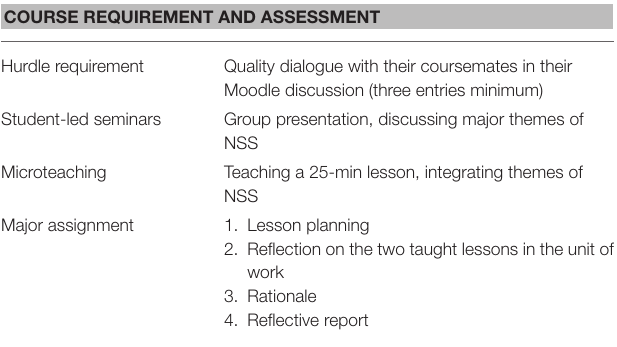
TABLE 3 | Overview of assessment tasks in Nancy’s